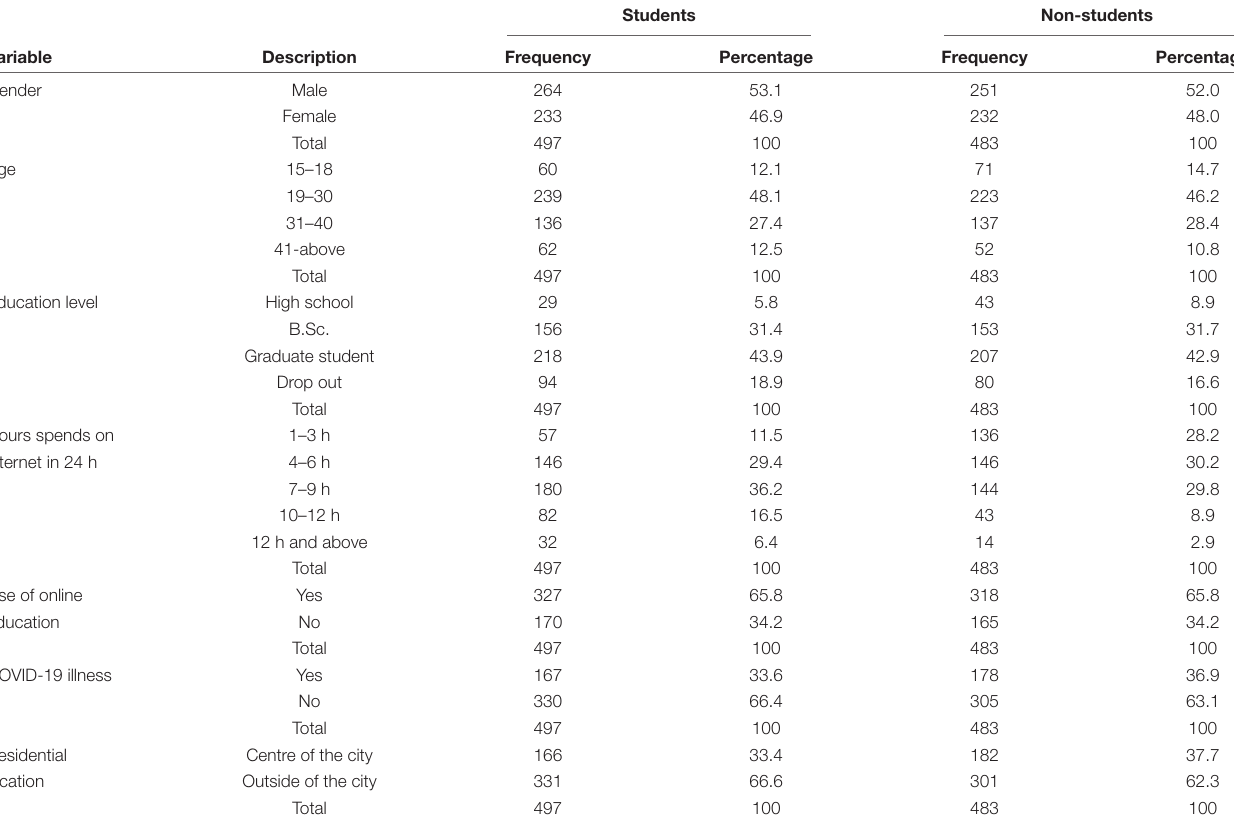
TABLE 2 | Demographic